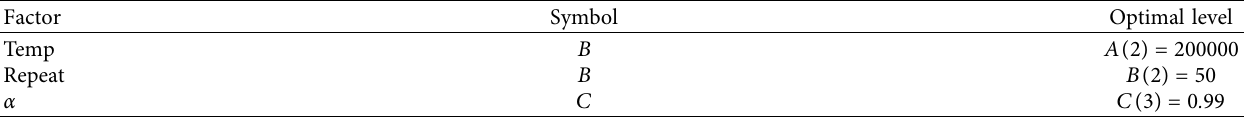
Table 10: Optimum levels of SA parameters in large size